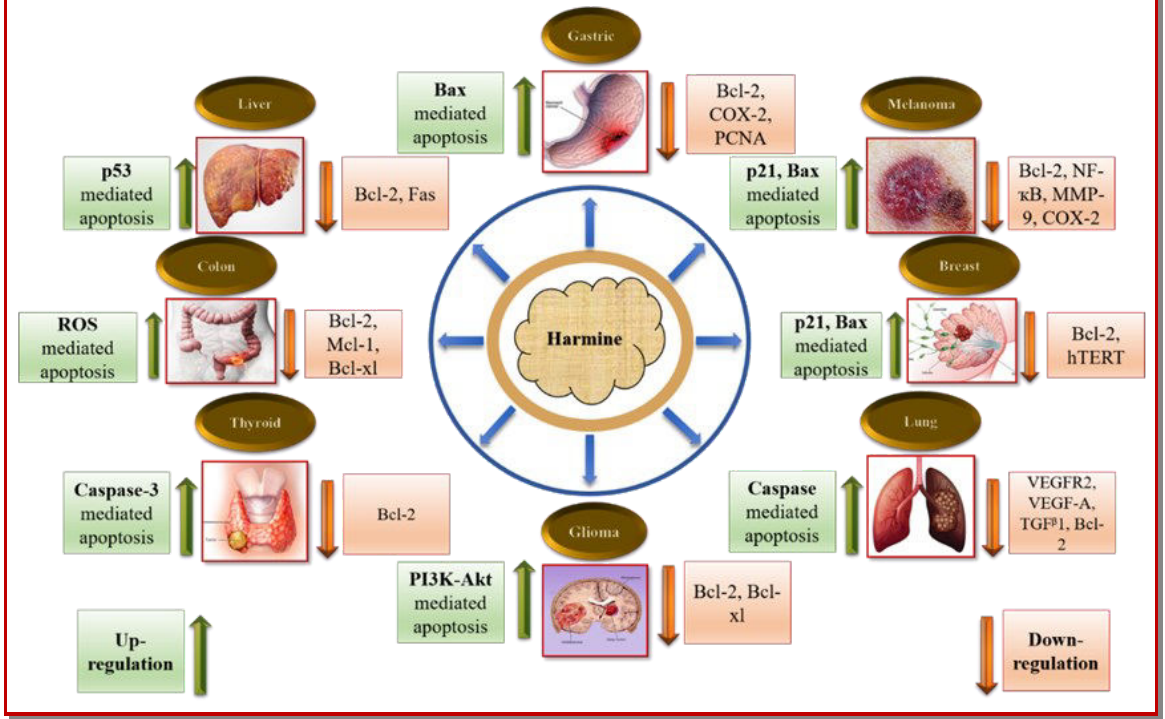
Figure 3: Diagram representing organ-based anti-cancer activity of harmine and its